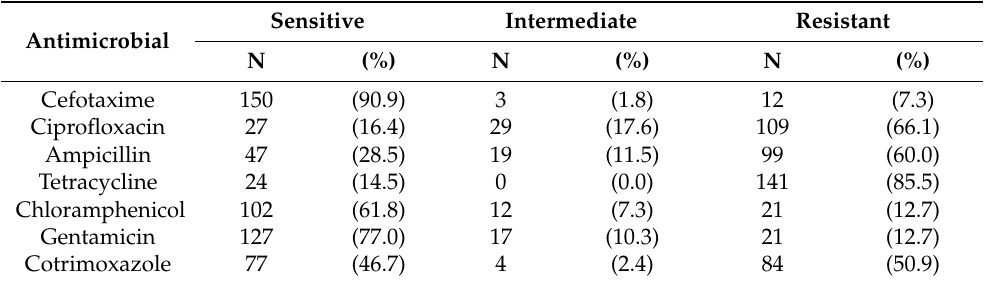
Table 2. Pattern of resistance among E. coli isolated from chicken cecal samples in the Dhulikhel municipality of Nepal from September to December 2021 (N = 165). Sensitive Antimicrobial